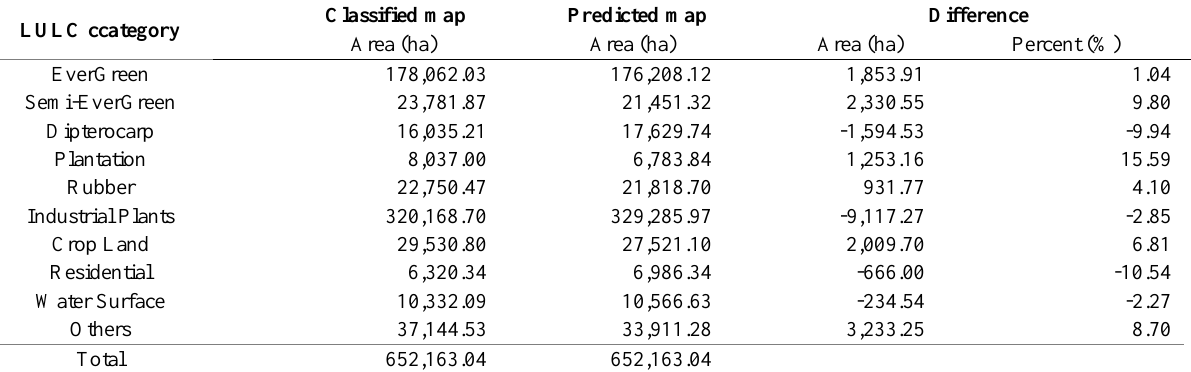
Table 3. Comparison of classified and simulated LULC maps in 2018